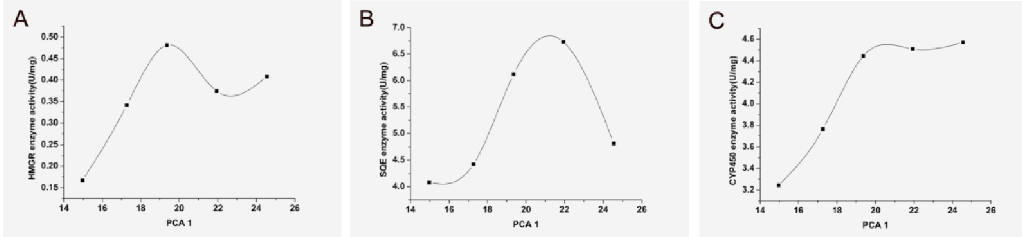
Fig 6. Effect of PCA1 on the activity of rate-limiting enzymes in the synthesis of ginsenosides. A: The relationship of HMGR enzyme activity in ginseng with PCA1;B: The relationship of SQE enzyme activity in ginseng with PCA1;C The relationship of CYP450 enzyme activity in ginseng with